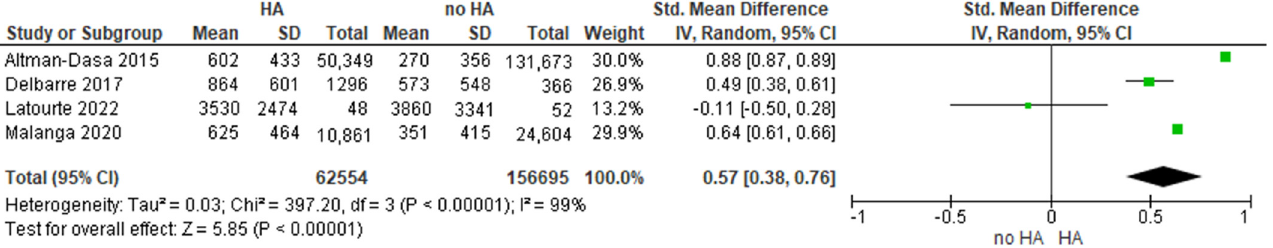
Figure 2. Forest plot of effect of IA HA injection against time from KOA declared diagnosis in the database to TKA. HA = hyaluronic acid, SD = standard deviation, Std mean difference = standard mean difference, 95% CI = confidence interval.